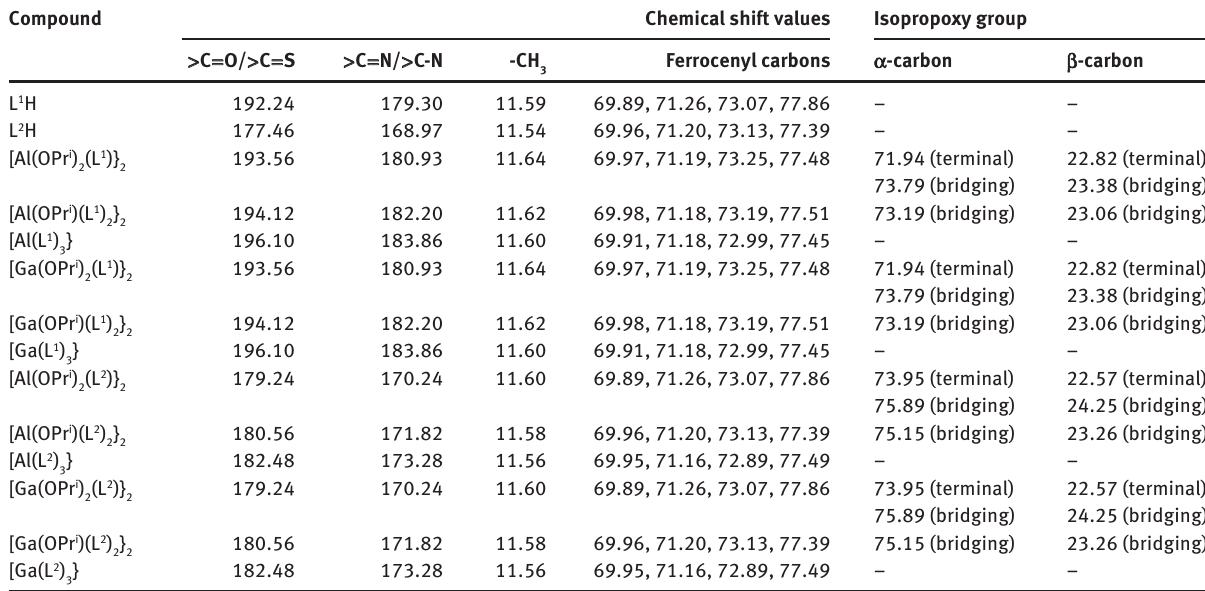
Table 3 13 C NMR spectral data ( δ , ppm) of the ligands and corresponding metal complexes.